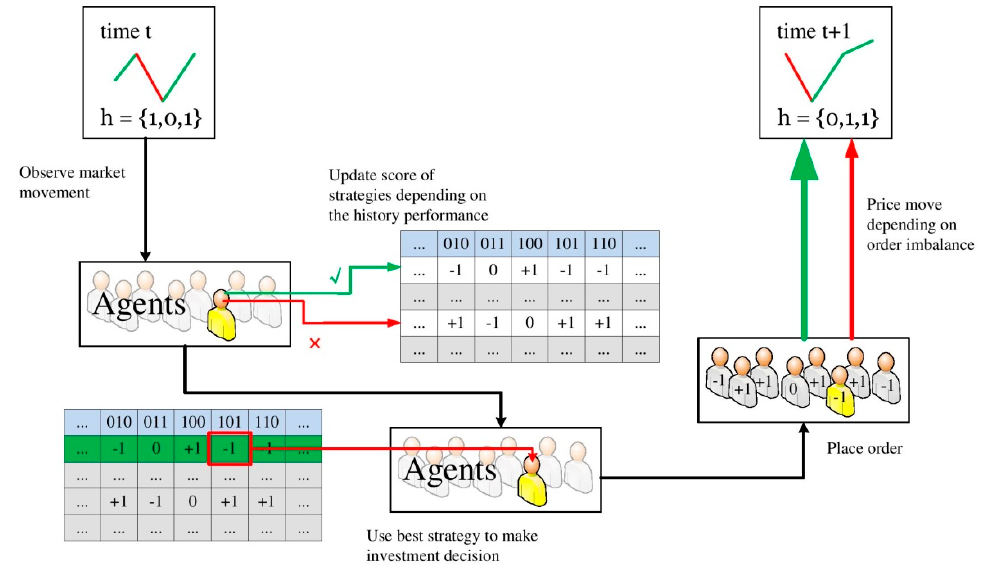
Figure 1. Representation of the price dynamics in the Minority Game (Challet and Zhang 1997) and the $-Game (Andersen and Sornette 2003). Agents first update the scores of all their strategies depending on their ability to predict market movements. After the scores have been updated, each agent chooses the strategy that now has the highest score. Depending on the price history at that moment, this strategy determines which action a given agent will take. Finally, the sum of the actions of all agents determines the next price move: if positive, the price moves up, if negative, the price moves down.